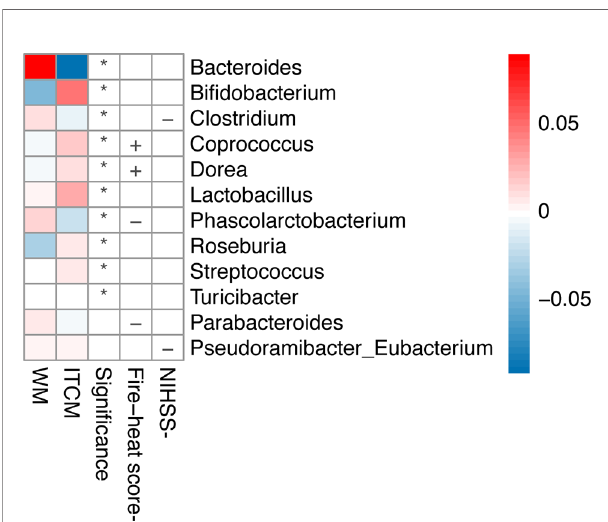
FIGURE 3 | Genera changed differentially in the two treatment groups and correlations between the change of genus and clinical outcome. The fi rst two columns represented the abundance changes of genera which were differentially altered in the two treatment groups. The third column represented the signi fi cance of abundance changes in the between-group comparison (Wilcoxon rank-sum test, p < 0.05). The last two columns represented the correlations between the change of genus and clinical outcome, where the clinical outcomes were evaluated by the decrease of NIHSS score or the fi re-heat score * p ≤ 0.05; +, positive correlation; -, negative